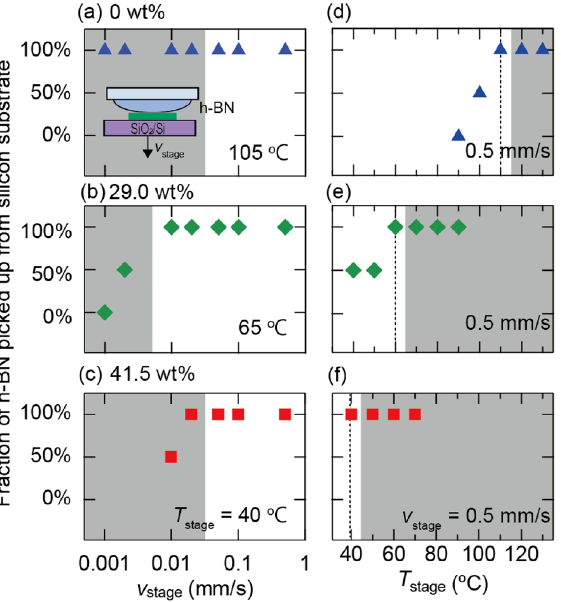
Figure 2. ( a – c ) Fraction of h-BN flakes picked up by Elvacite2552C-IL compounds from a silicon substrate with different speeds (cid:31) v stage (cid:30) to detach the silicon substrate from the compounds for IL contents (a) 0 , (b) 29.0 , and ( c ) 41.5 wt% at stage temperatures ( a ) T stage = 105 , ( b ) 65 , and ( c ) 40 transferred from the silicon substrate to Elvacite2552C-IL compounds for varying stage temperatures (cid:31) T stage (cid:30) at = 0.5mm / s . The gray shaded regions indicate the ranges of v v stage